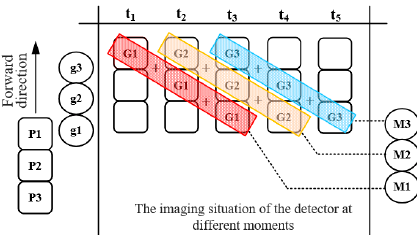
Figure 2. The principle of the digital domain time-delayed integration (TDI).